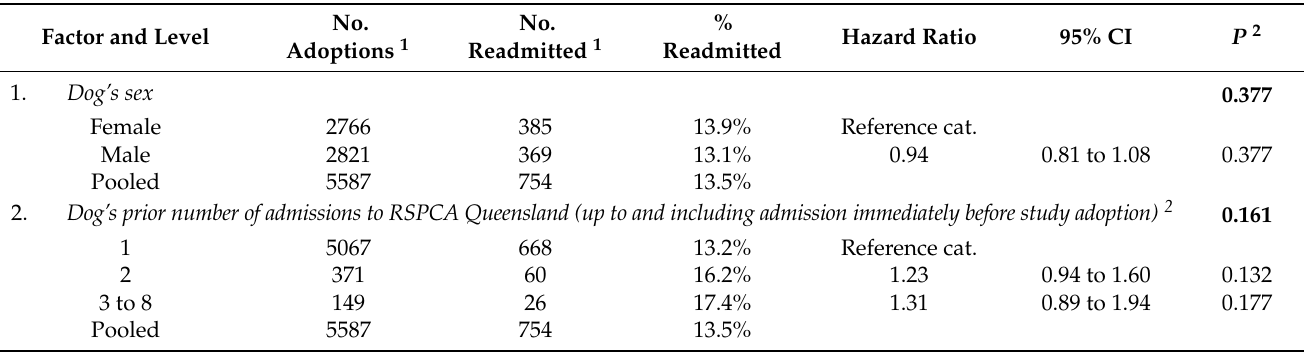
Table 1. Descriptive statistics and hazard ratio estimates for exposure variables with high overall p -values on univariable analyses of associations with time to readmission for dogs adopted from RSPCA Queensland in 2019 and